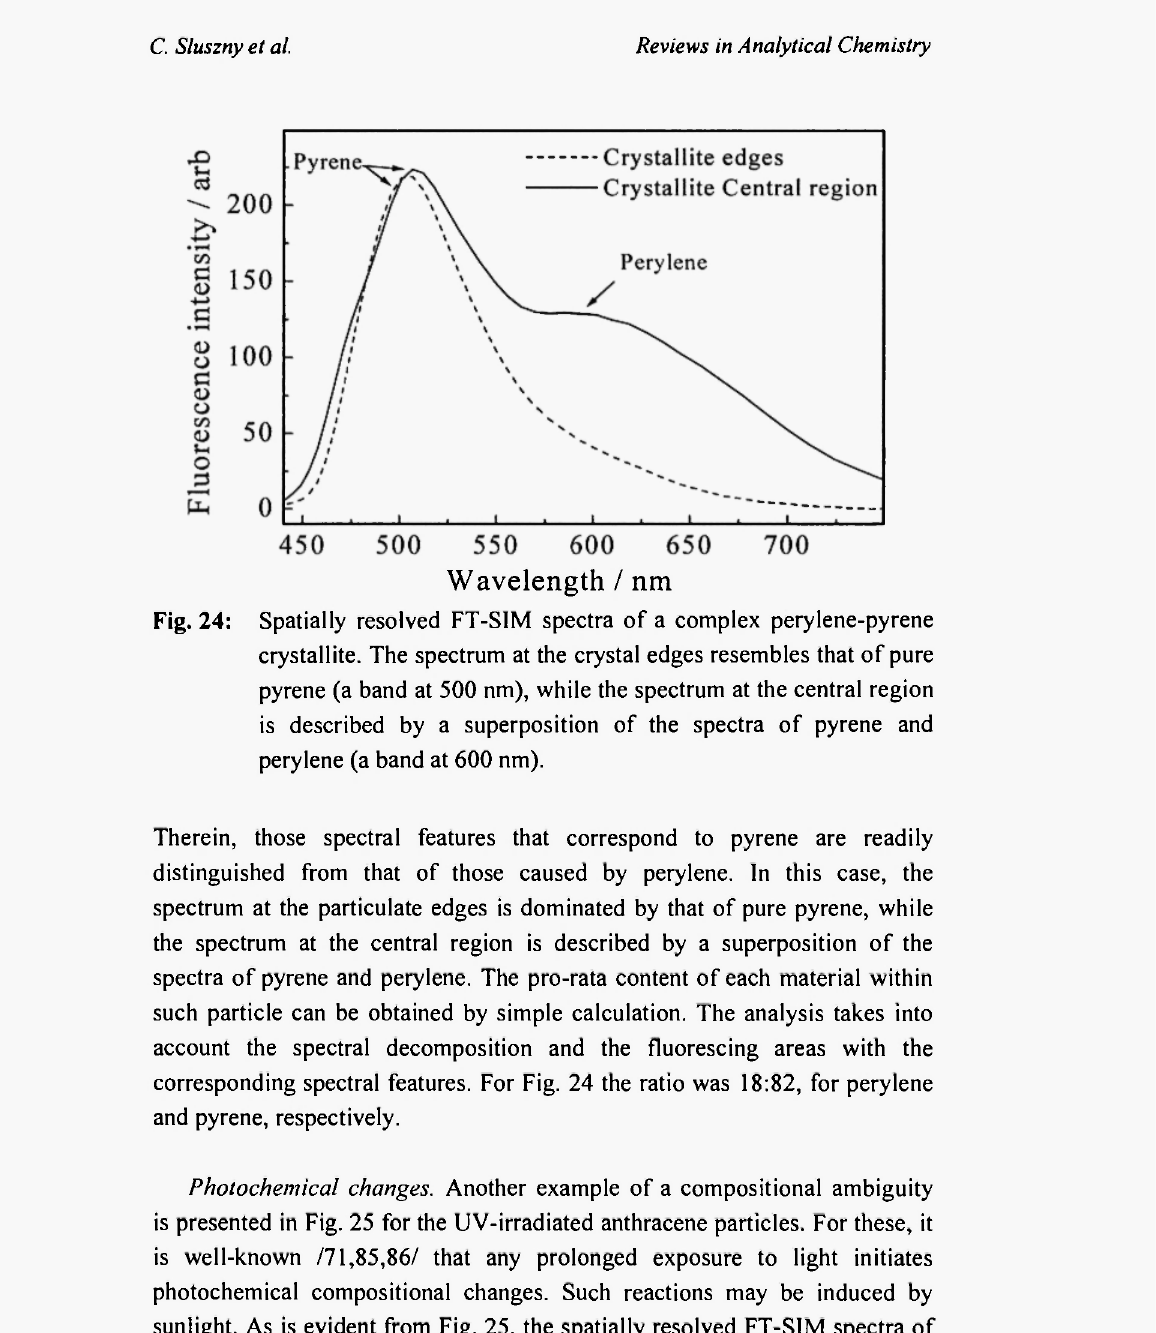
Fig. 24: Spatially resolved FT-SIM spectra of a complex perylene-pyrene crystallite. The spectrum at the crystal edges resembles that of pure pyrene (a band at 500 nm), while the spectrum at the central region is described by a superposition of the spectra of pyrene and perylene (a band at 600